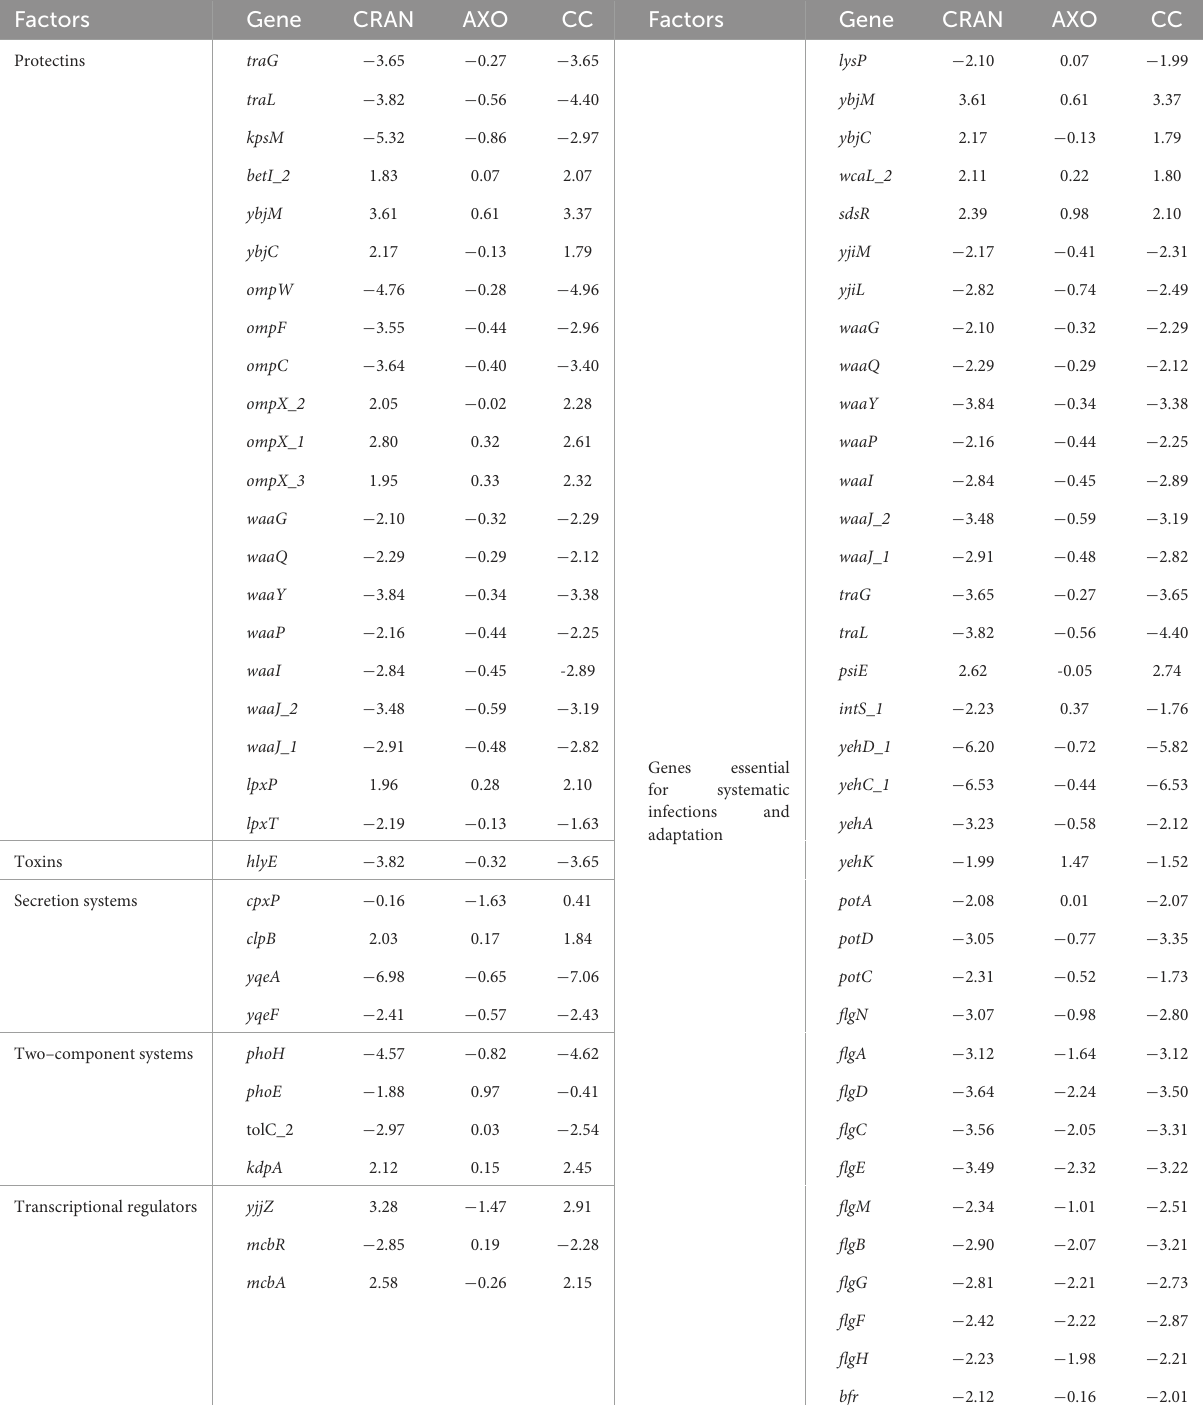
TABLE 3 Differentially expressed virulence and pathogenesis genes in E. coli O7:H18 (ST38) exposed to 4 mg/mL of CRAN, 4 µ g/mL of AXO, and 4 µ g/mL AXO + 4 mg/mL CRAN (CC). Factors Gene CRAN AXO CC Factors Gene CRAN AXO CC Protectins